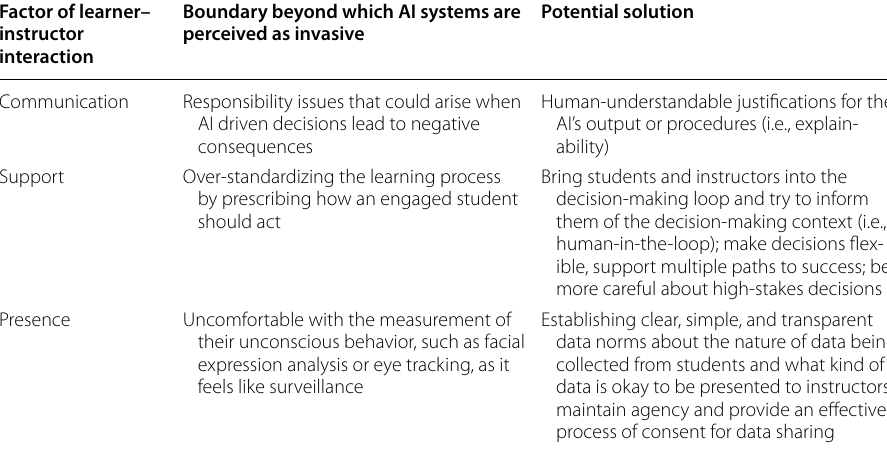
Table 6 Summary of the boundaries beyond which AI systems are perceived as invasive, and